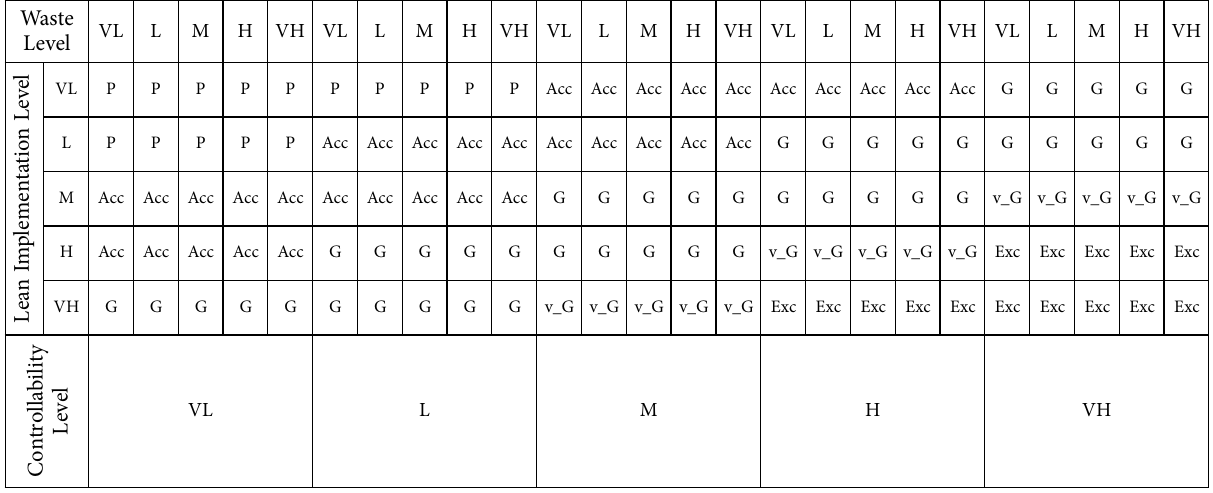
Table 4. FAMs rules for inputs and output in Level 02 of LCEM